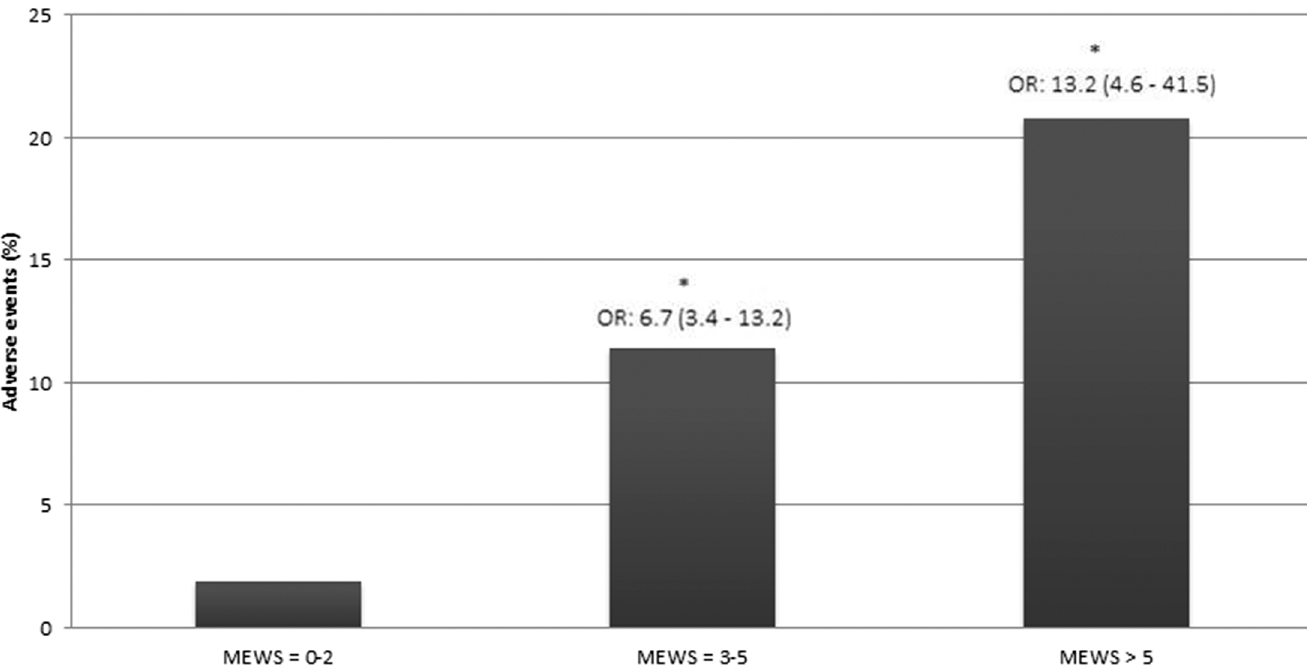
Fig 4. Adverse events compared between MEWS groups. Significant with MEWS < 3 with a p-level of p < 0.001. OR = Odds ratio.